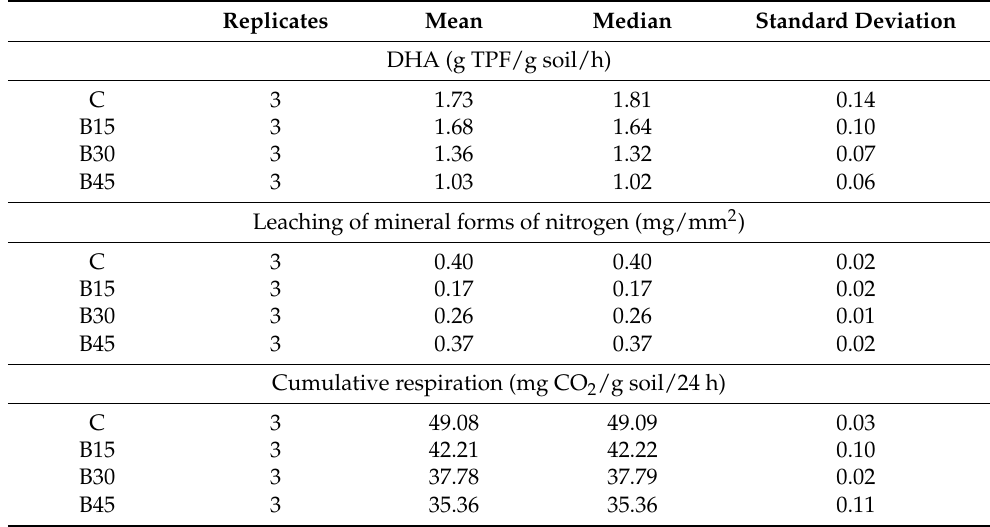
Table 5. Effect of biochar dose on DHA, leaching of mineral forms of nitrogen, and cumulative soil respiration.